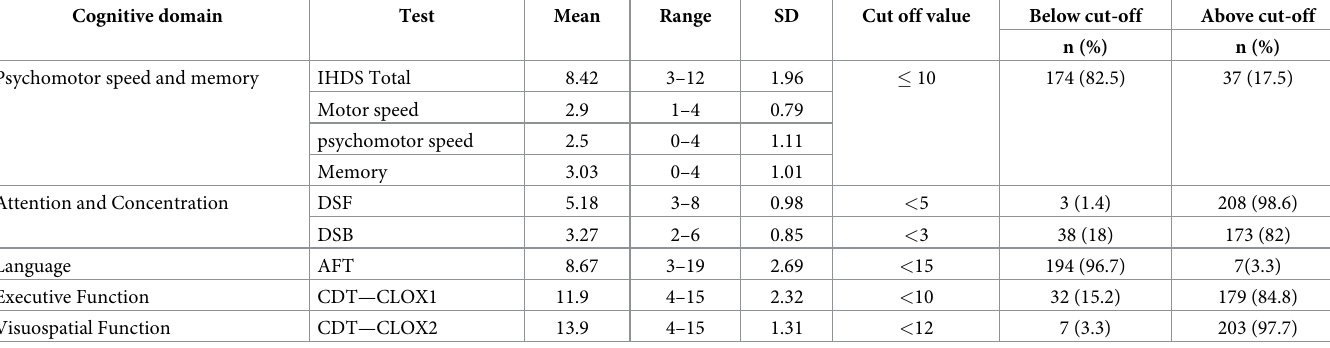
Table 3. Performance on neuropsychological